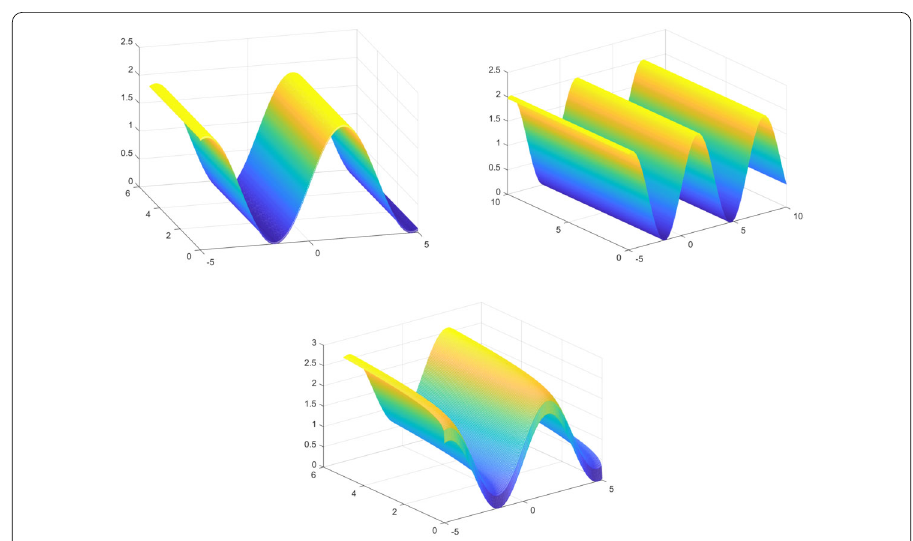
Figure 1 Graph of u ( x , t ) at α = 0.01, 0.02, and 0.1 of Example